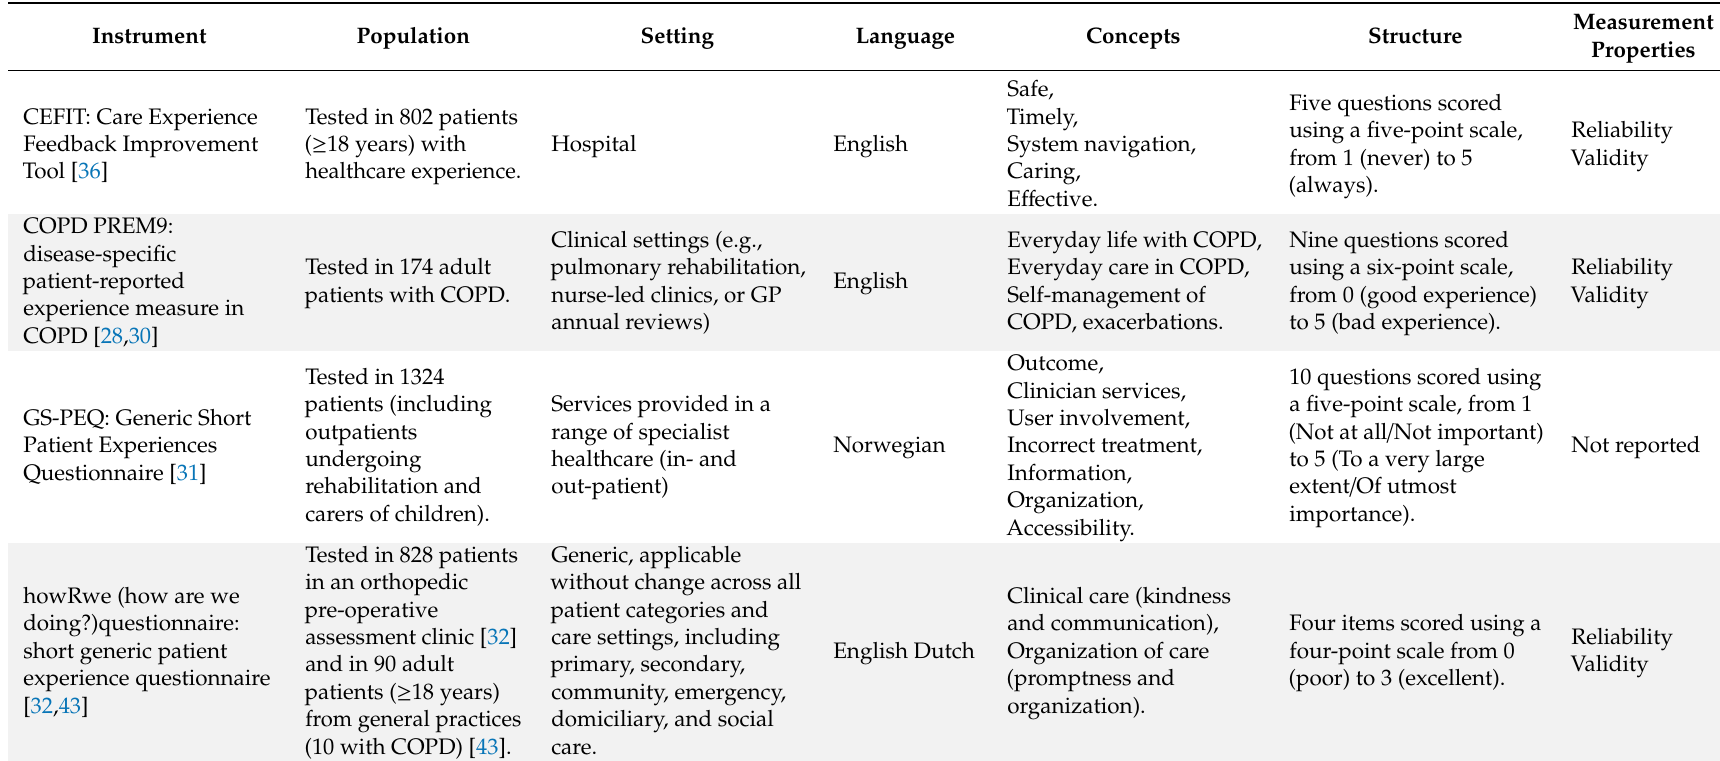
Table 2. Instruments designed to assess patient’s experience with the provision of